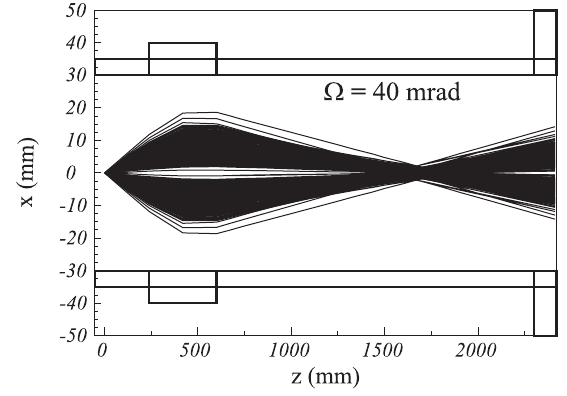
FIG. 7. Sample trajectories through solenoid collector and (cid:2) E=E ¼ (cid:2) 0 : 05 . different rotation in phase space for different energy slices, where bunch tail particles (lower energy) are ahead in the (clockwise) rotation. The ellipse indicates the emittance including 95% of particles. Figure 8 also indicates that the 95% emittance is a somewhat pessimistic definition, since the hourglass shape of the distribution has a strong con- centration of density in the center. Discarding a larger fraction of particles leads to smaller values of emittances. The 85% emittance, for example, is only about 1 = 2 of the 95% emittance.